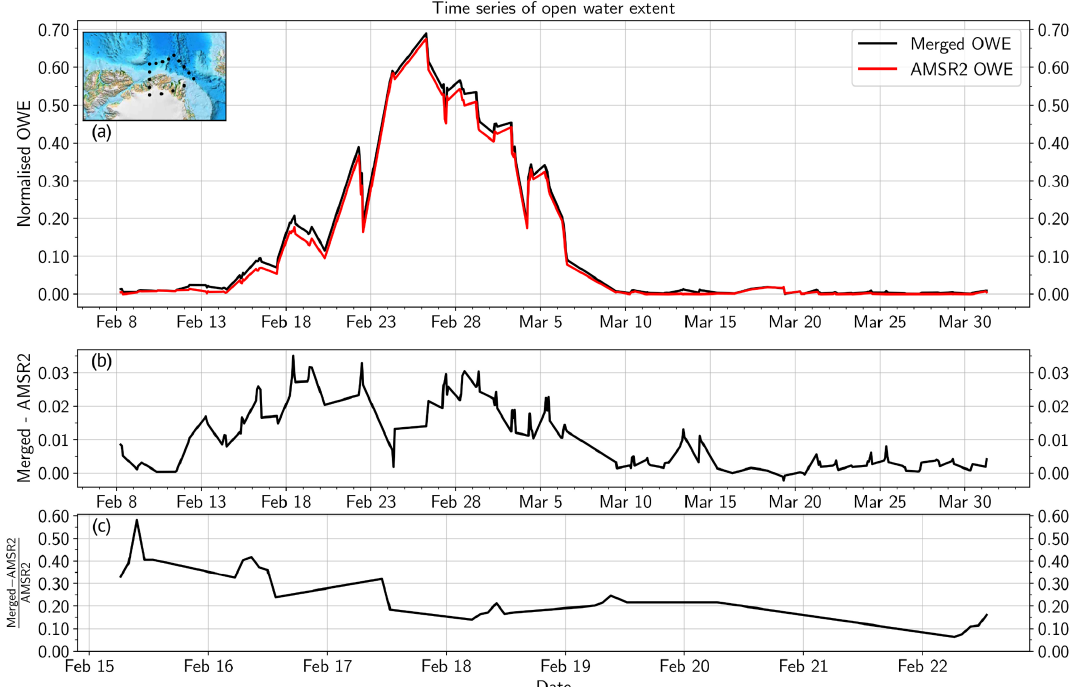
Figure 4. Time series of the merged and AMSR2 open water extent. Panel (a) shows the open water extent for both datasets. It was normalised to the number of cloud-free pixels. Panel (b) shows the difference of the merged and the AMSR2 open water extent. Panel (c) shows the normalised difference of the two datasets during the opening phase. Note the different time span of panel (c) . Only points for which MODIS data were available were considered for all three